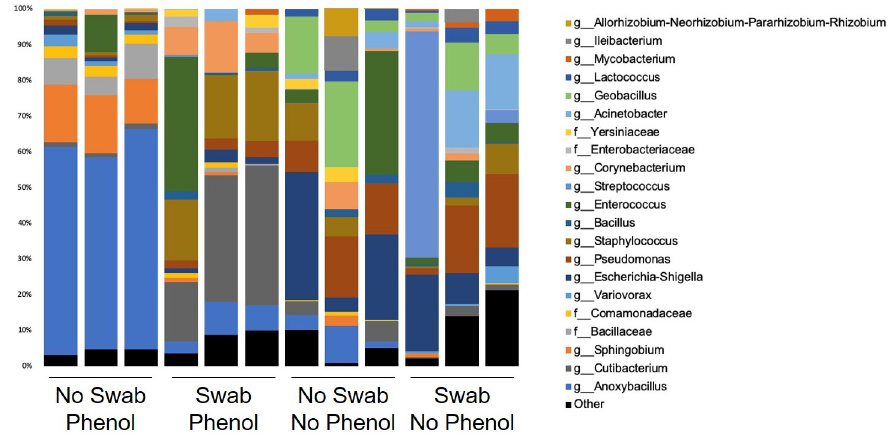
Fig 2. Percent abundance of taxa for which 16S rRNA sequences were amplified from negative extraction control samples under each of 4 DNA isolation conditions.